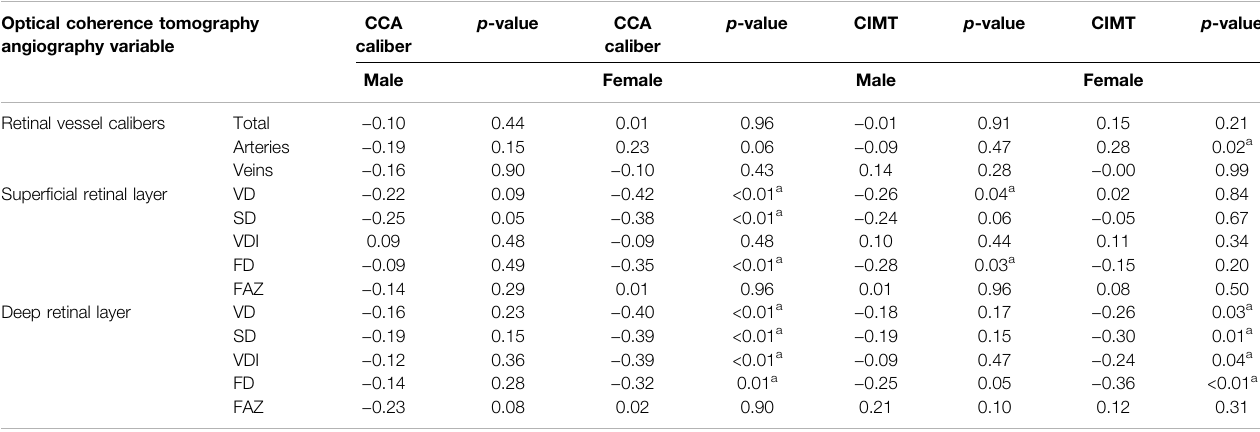
TABLE 3 | Correlation between CCA caliber diameter, CIMT, and optical coherence tomography angiography-derived retinal vascular metrics adjusted for age and blood pressure. Optical coherence tomography angiography